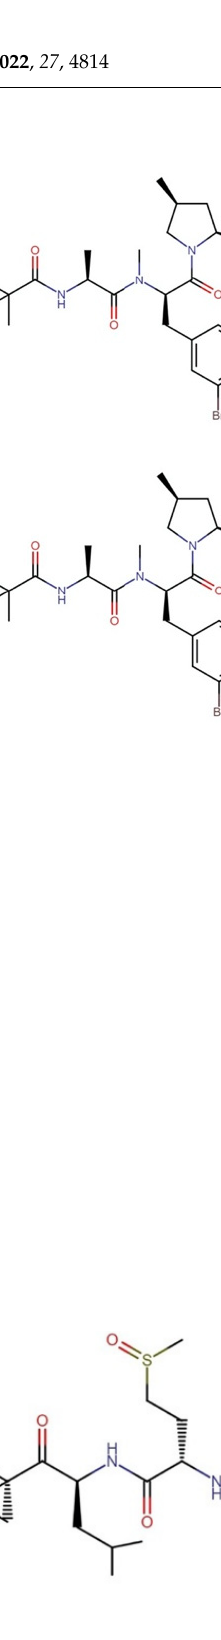
Figure 5. Chemical structures of ( a ) carmaphycin A and ( b ) carmaphycin